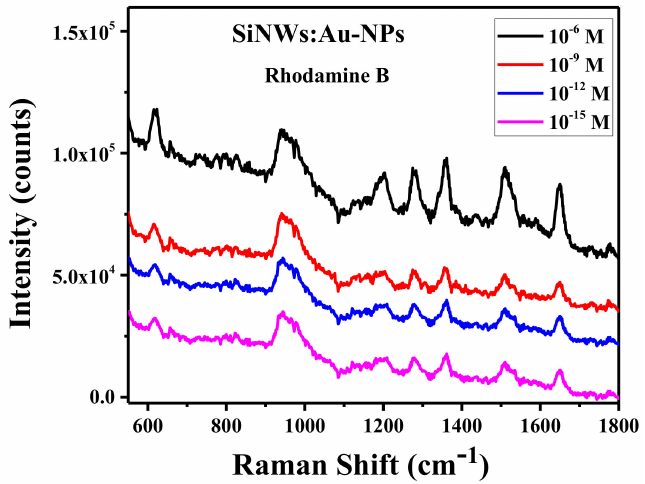
Figure 9. SERS spectra of SiNWs:Au-NPs with P = 55 % after deposition of Rhodamine B with different molar